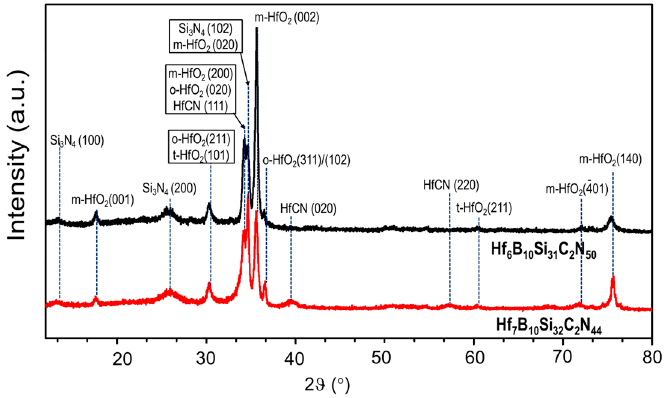
Figure 1. θ –2 θ XRD spectra of the annealed Hf 7 B 10 Si 32 C 2 N 44 and Hf 6 B 10 Si 31 C 2 N 50